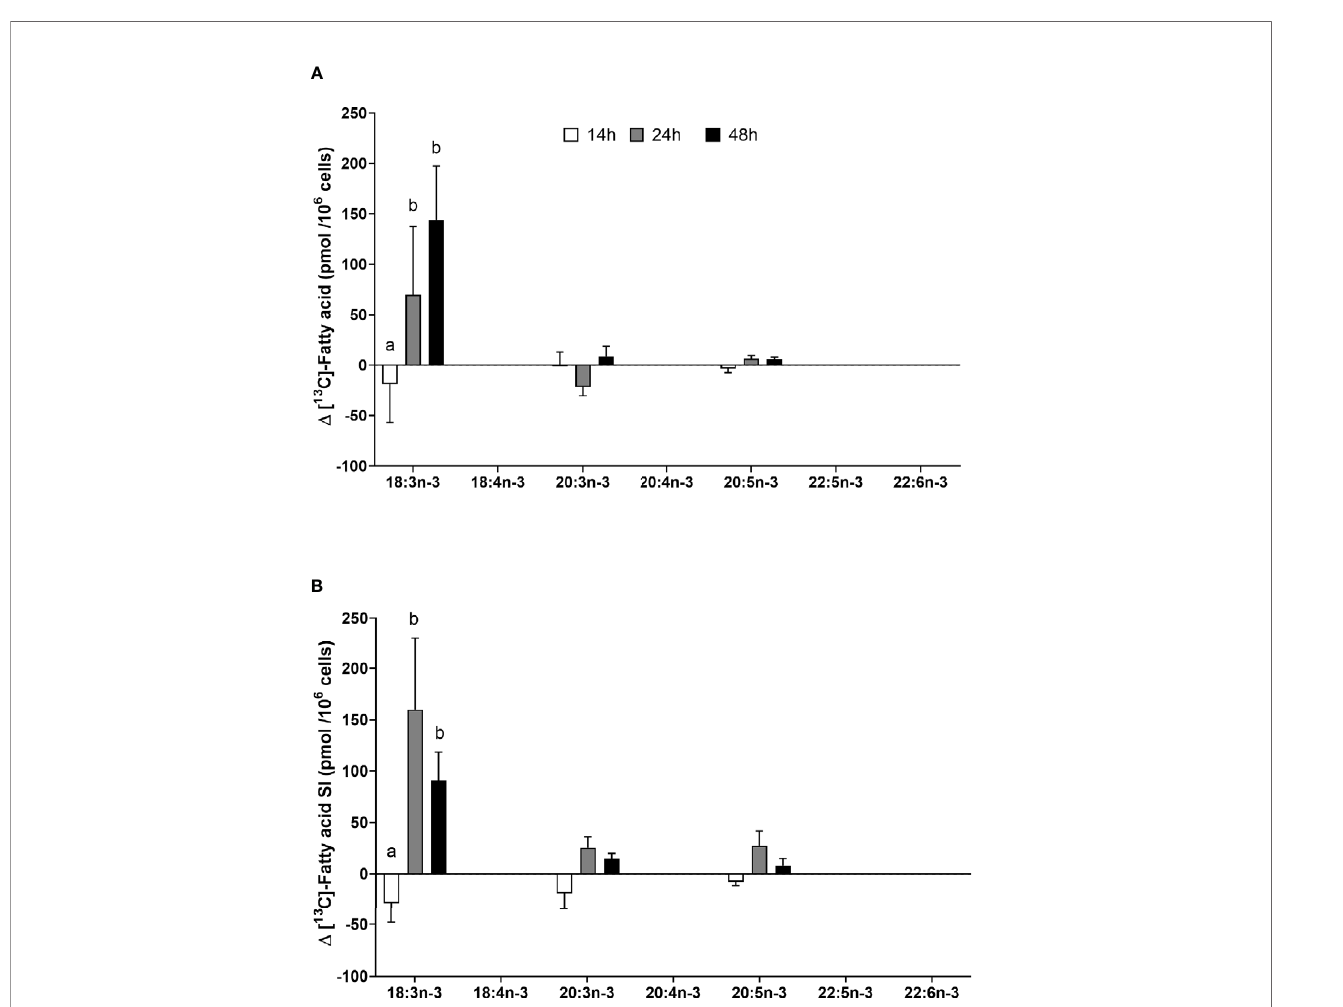
FIGURE 6 | The effect of duration of incubation and essential fatty acid (EFA) ratio on the mitogen-induced change in the amount of [ 13 C] n-3 polyunsaturated fatty acids (PUFAs) in CD3 + T cells. Values are mean ± SEM (n = 10/time point) change in the amount of labelled longer-chain PUFA (LCPUFA) after 14-, 24-, and 48-h incubation in media containing an EFA ratio of (A) 5:1 or (B) 8:1. Means represented by bars with different letters were signi fi cantly different by two-way ANOVA with Tukey ’ s post-hoc test ( Table 4